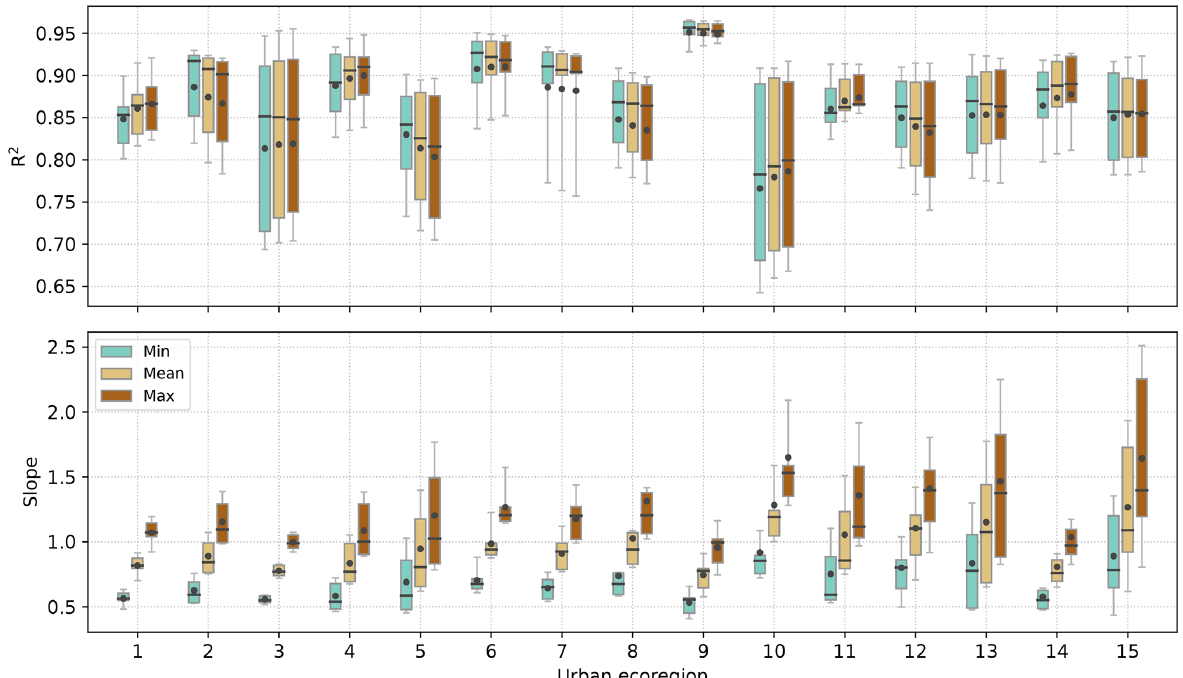
Figure I2. Coefficients of determination ( R 2 ) and slopes resulting from the regression between the reference dataset for λ B and the corre- sponding universal LCZ-based values from Stewart and Oke (2012), using minimum, mean, and maximum values (colours), for all FUAs stratified per ecoregion. Coloured boxes and grey whiskers span the 25th–75th and 5th–95th percentiles respectively. The means and medians are indicated by the black dots and lines